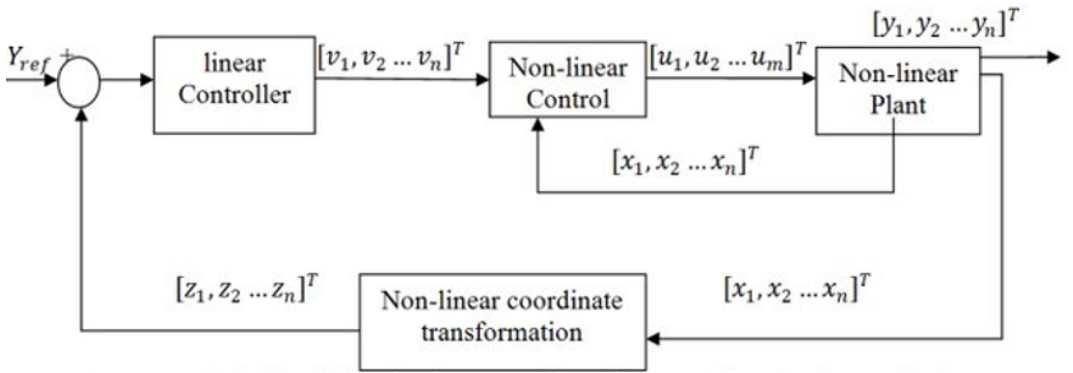
Figure 18. Schematic representation of the internal structure of FLC